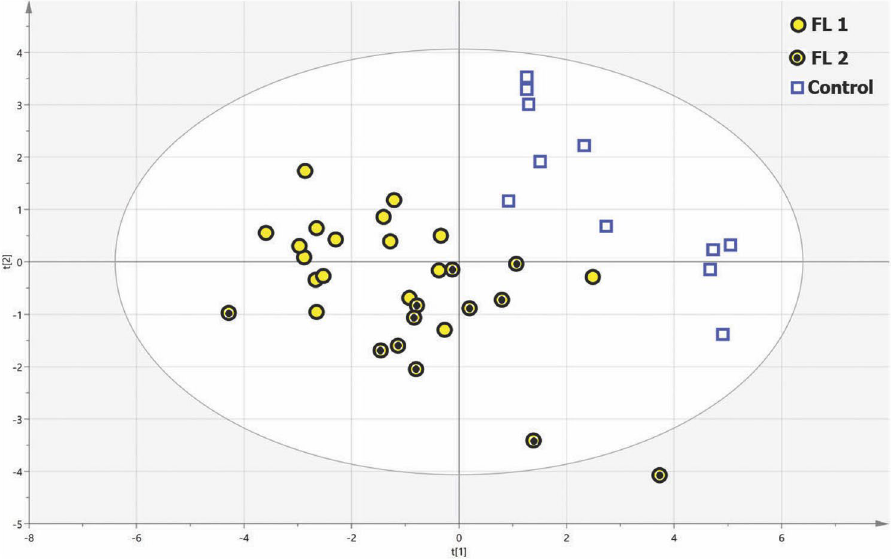
Figure 1. Partial least squares discriminant analysis highlights a very predictive (R 2 Y = 0.777, Q 2 Y = 0.639) and significant (p = 2.5e−07) separation between FL cases (including subsets FL1 and FL2) and controls using 28 metabolites (with a variable importance in projection >